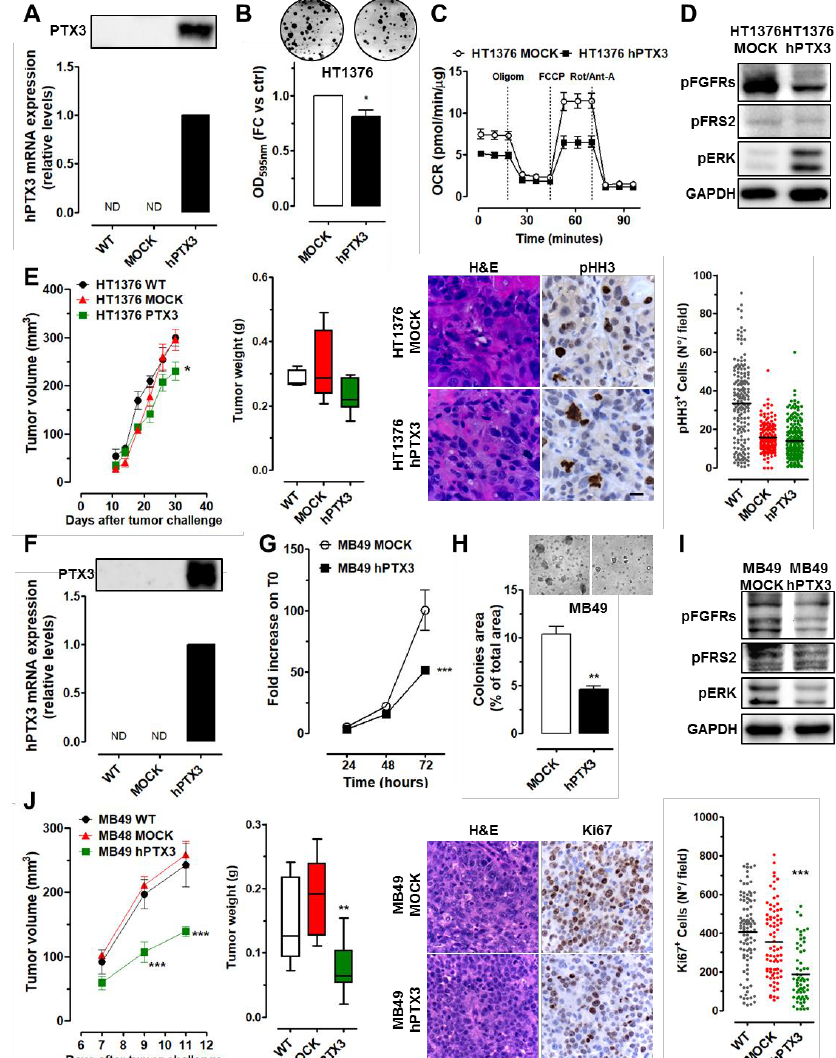
Figure 4 . PTX3 modulation in high-grade/invasive HT1376 and MB49 BC cells. ( A ) PTX3 expression (mRNA and protein levels) of PTX3 transduced (hPTX3), control (Mock), and wild-type (WT)